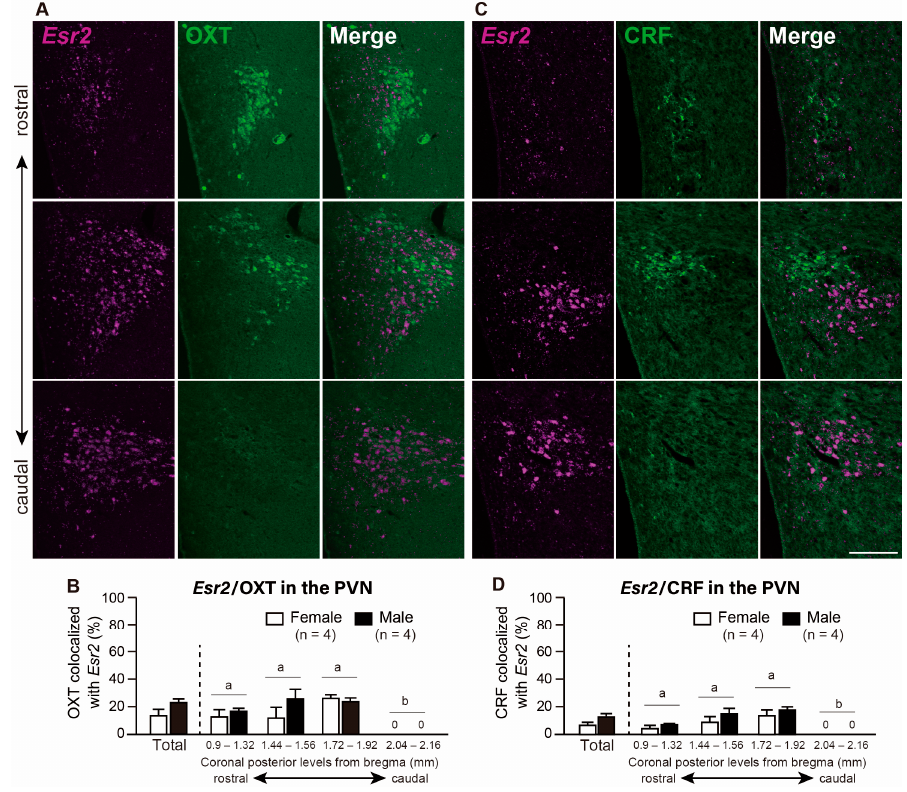
Figure 4. Co-expression of Esr2 / oxytocin (OXT) and Esr2 / corticotropin-releasing factor (CRF) in the paraventricular nucleus of the hypothalamus (PVN). Representative photomicrographs show dual labeling of Esr2 mRNA (magenta) and OXT (green) in the PVN of female rats ( A ), and dual labeling of Esr2 mRNA (magenta) and CRF (green) in the PVN of female rats ( C ). Arrowheads indicate double-labeled cells. Scale bar indicate 200 µ m in A and C. The bar graph shows the percentage of co-expression of Esr2 mRNA / OXT-ir cells ( B ) and Esr2 mRNA / CRF-ir cells ( D ) in the whole PVN and the PVN at different rostro-caudal levels (from bregma − 0.9 to − 2.16 mm). Values represent the mean ± SEM. Differences in values that are significantly ( p < 0.05) different from each other are indicated by letters * p < 0.05.